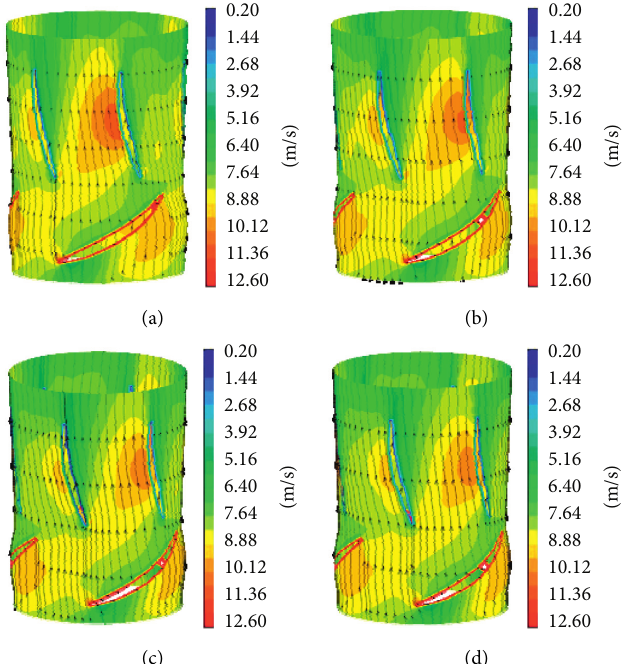
Figure 16: Flow fields of middle tori of the pump segment at different time in one period T ( Δ β � − 10 ° ). (a) t � 1/4 T , (b) t � 2/4 T , (c) t � 3/4 T , and (d) t � T